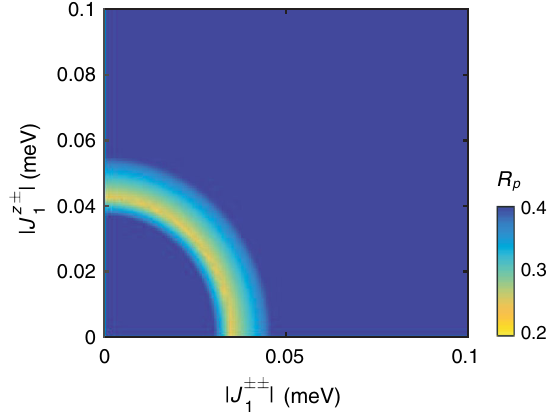
FIG. 5. Deviation R of the experimental TDTS spin-wave p resonance linewidths from the theoretically calculated ones as a function of the pseudodipolar interactions j J z (cid:2) 1 j and j J (cid:2)(cid:2) 1 j . This sets an upper bound on the pseudodipolar interactions in a model with J 2 ¼ 0